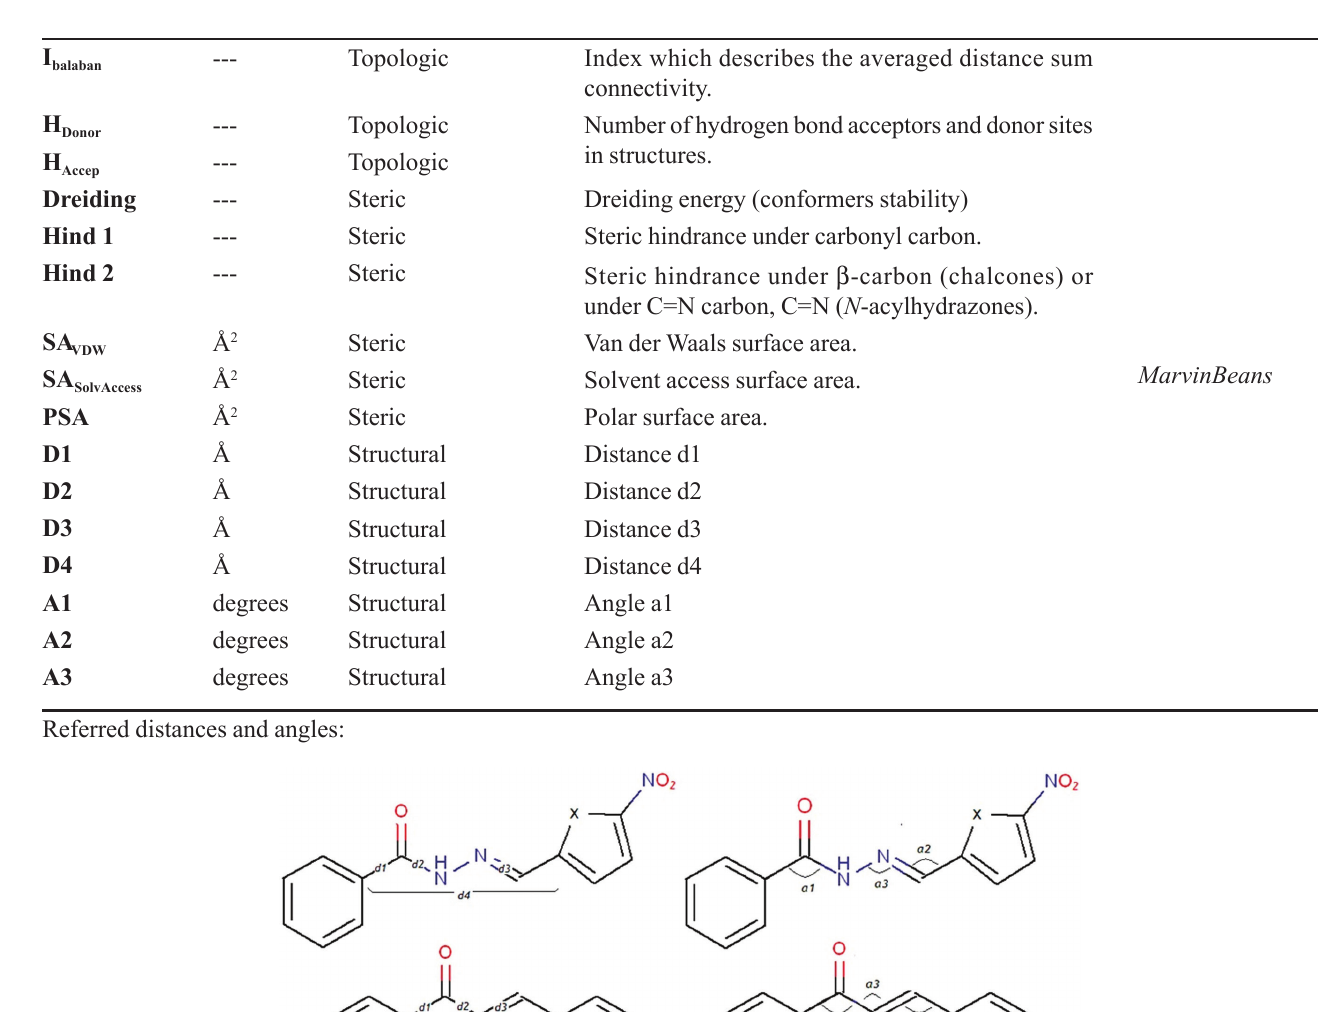
TABLE I - Descriptors calculated for the set studied